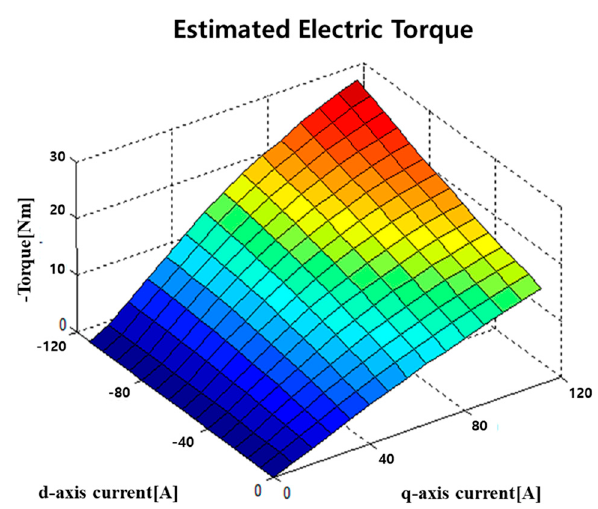
Figure 9. Estimated electric torque according to d-/q-axis currents.